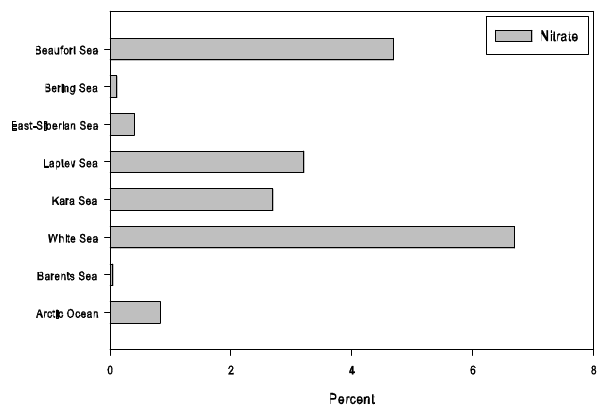
Fig. 7. Contribution of riverine nitrate to new primary production. (cid:0)